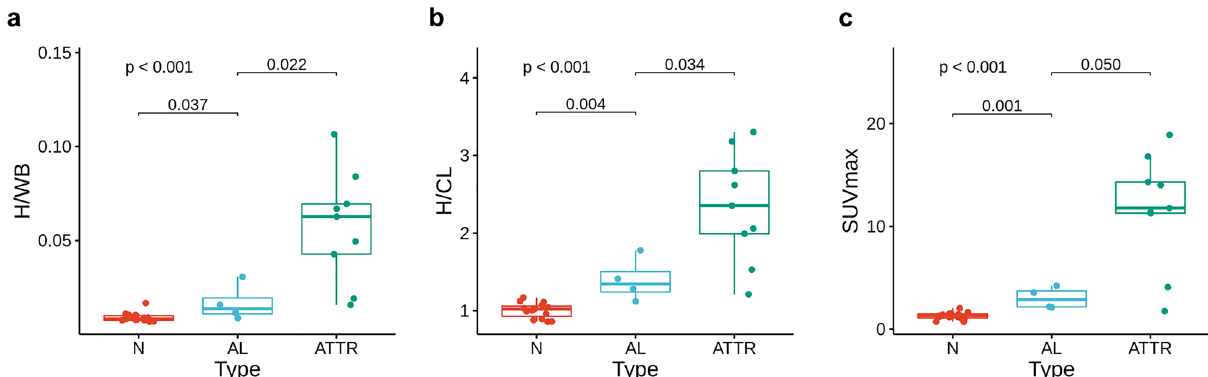
Figure 5. Quantitative indexes according to EMB results. H/WB, H/CL, and SUVmax were significantly higher in AL than in normal, and higher in ATTR than in